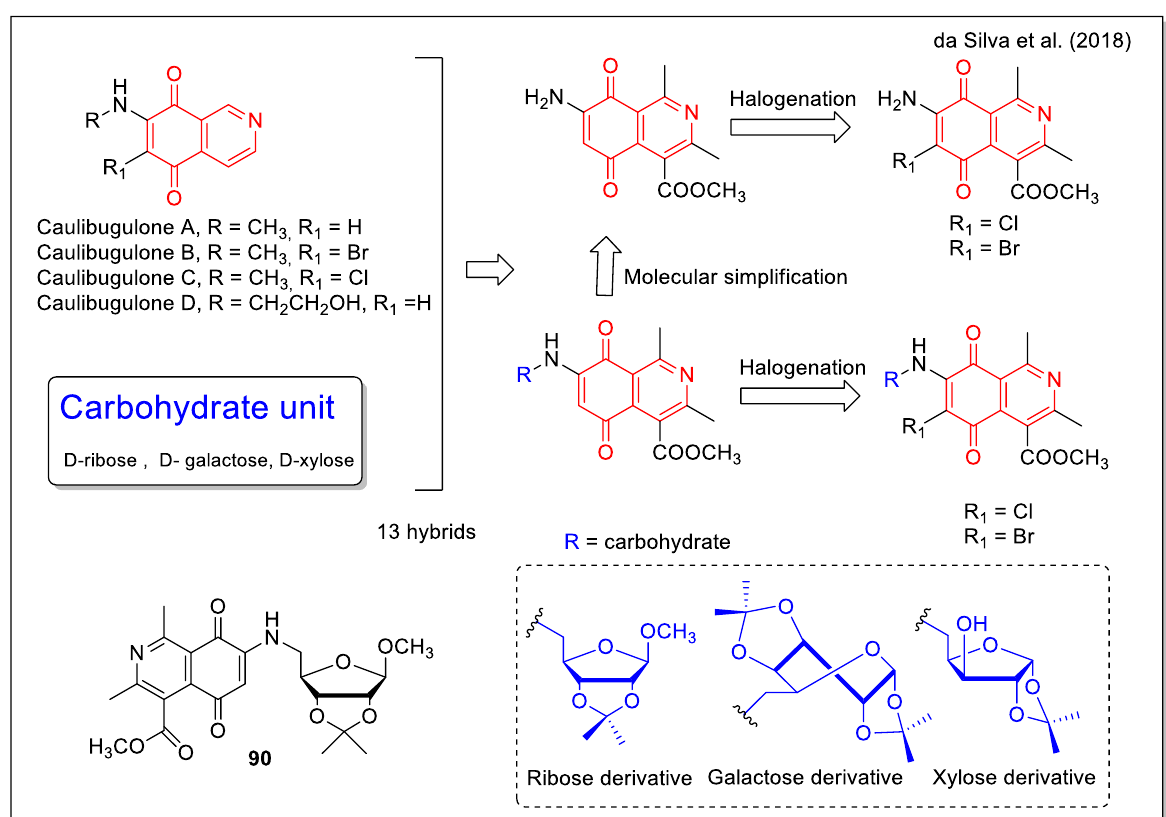
Figure 34. 5,8-Isoquinolinedione-carbohydrate hybrids as reported by da Silva et al. [77].